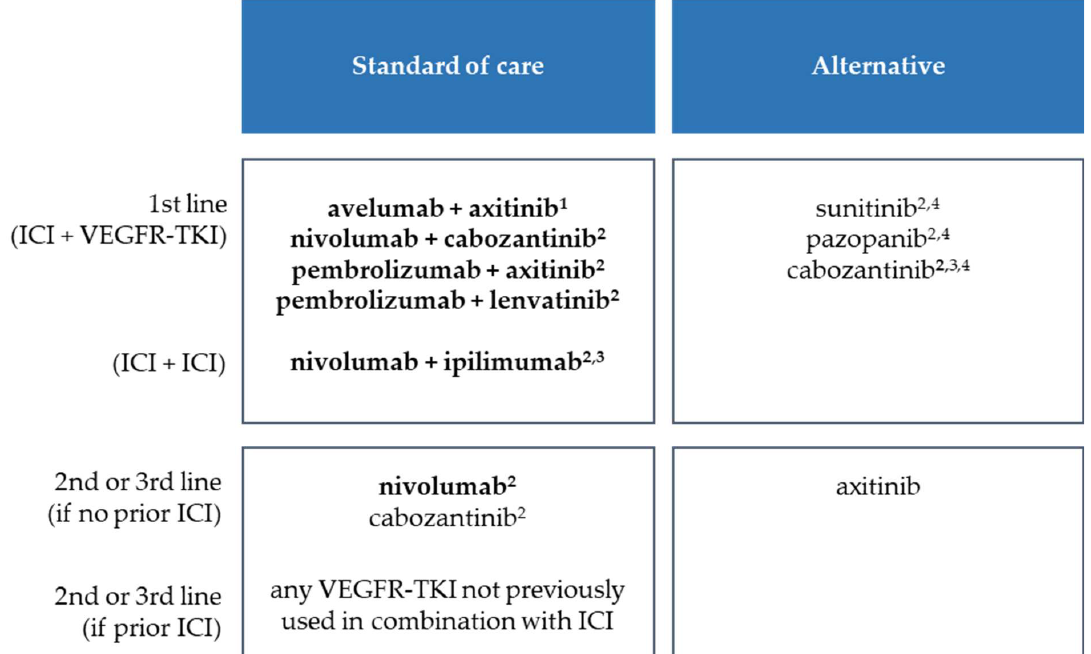
Figure 1. Currently approved and recommended therapies in advanced or metastatic renal cell carcinoma. Therapies with immune checkpoint inhibitor (ICI) component are highlighted in bold. According to EAU guideline Renal Cell Carcinoma [2]: 1 approved, but no recommendation by EAU, 2 strong recommendation, 3 for intermediate and poor risk only, 4 in patients with contraindications for ICI.